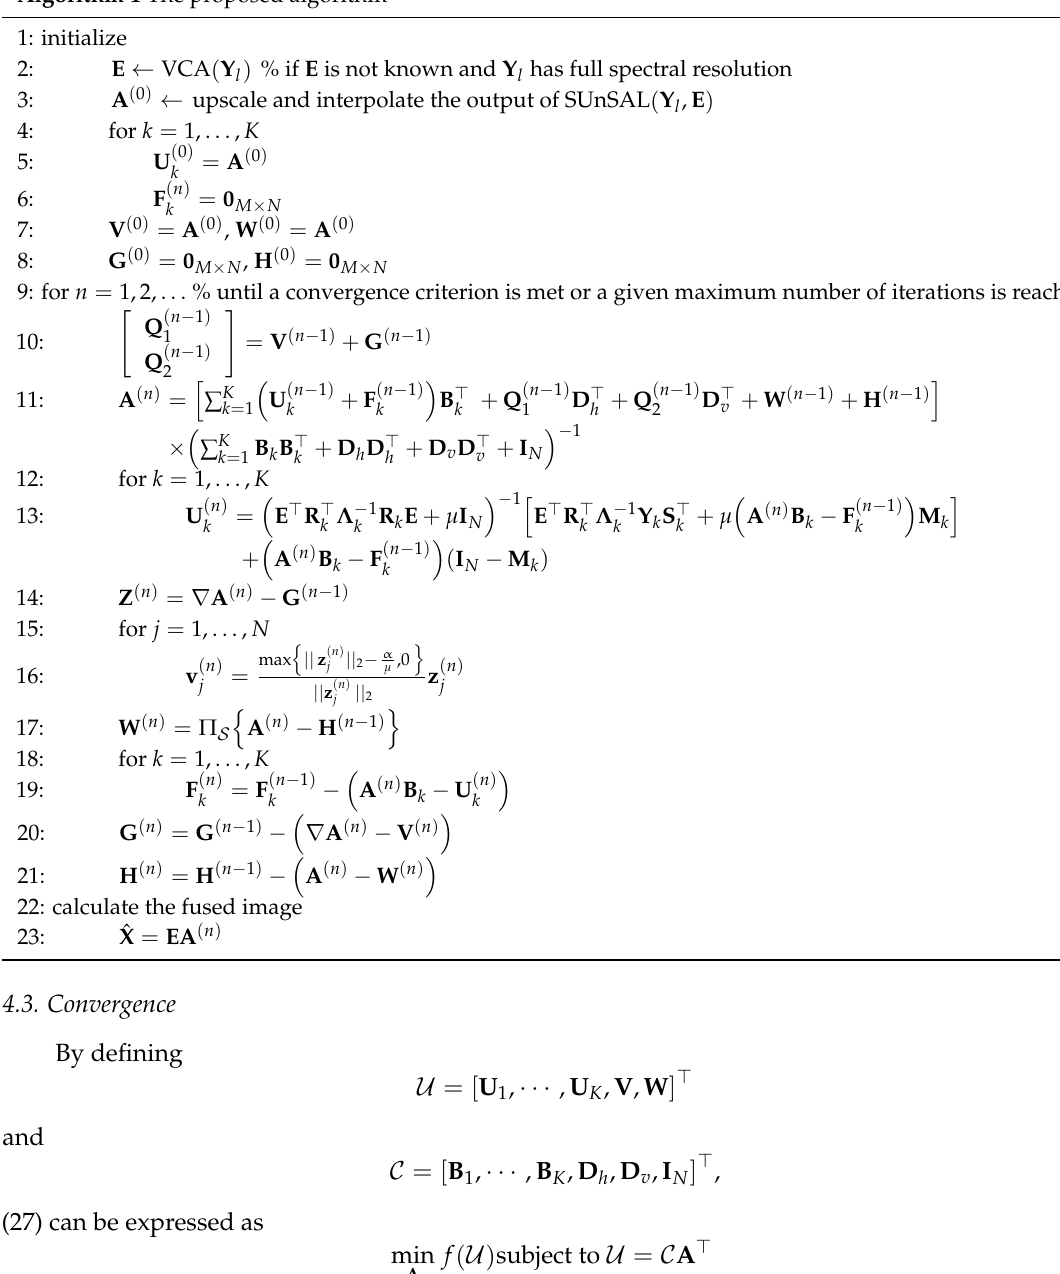
Algorithm 1 The proposed